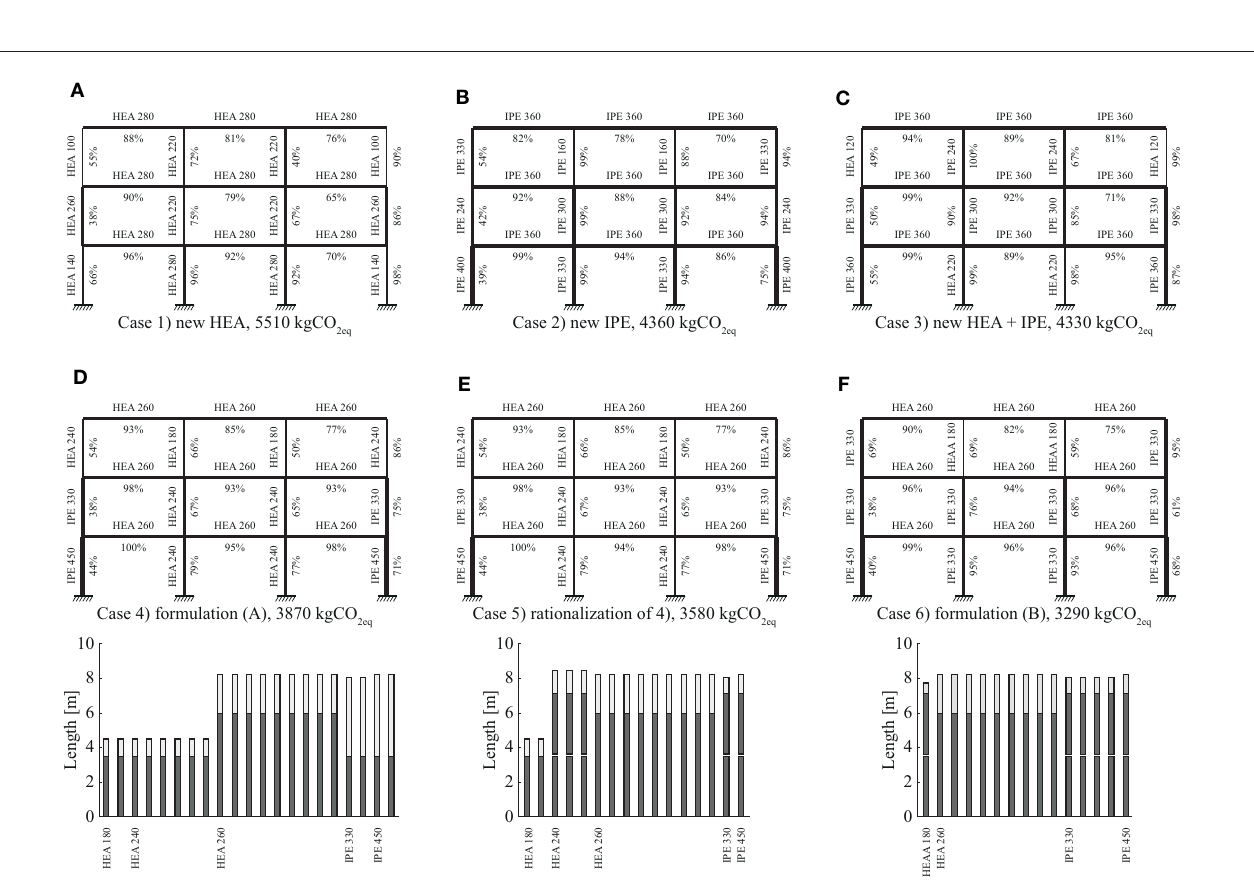
FIGURE 7 | Optimization results: (A–C) new steel minimum-weight benchmark cases (1)–(3); (D–F) optimum designs made of reused elements for cases (4)–(6) employing assignment and cutting stock optimization. Percentage values show the maximum cross-section utilization of each member.